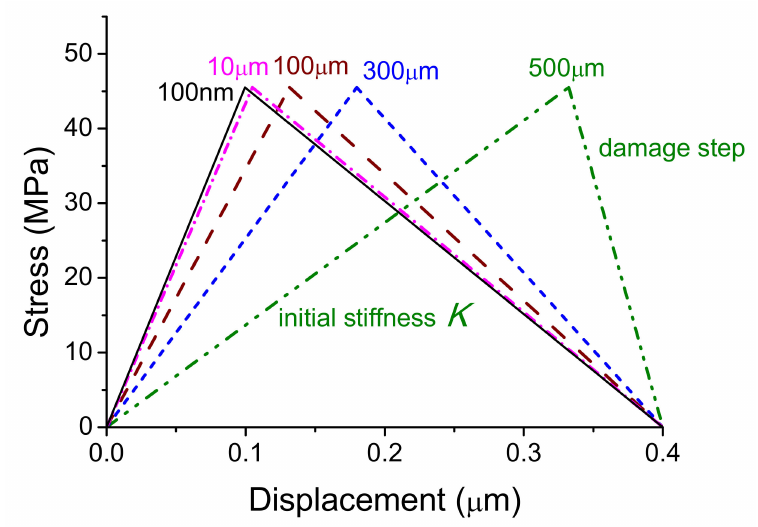
Figure 11. The relationships between tensile stress and total displacement of the systems with differ- ent film thickness from 100 nm, 10 µ m, 100 µ m, 300 µ m to 500 µ m (from left to right),